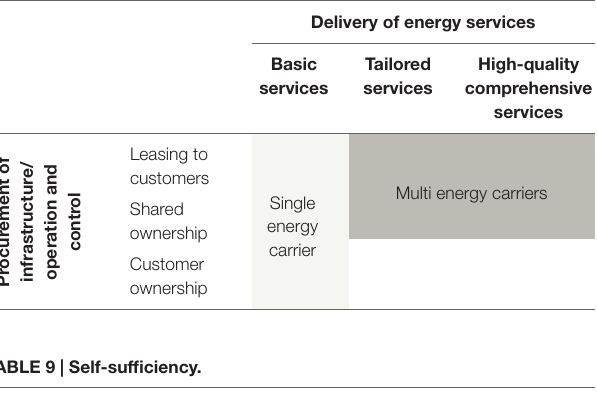
TaBle 8 | energy conversion infrastructures.